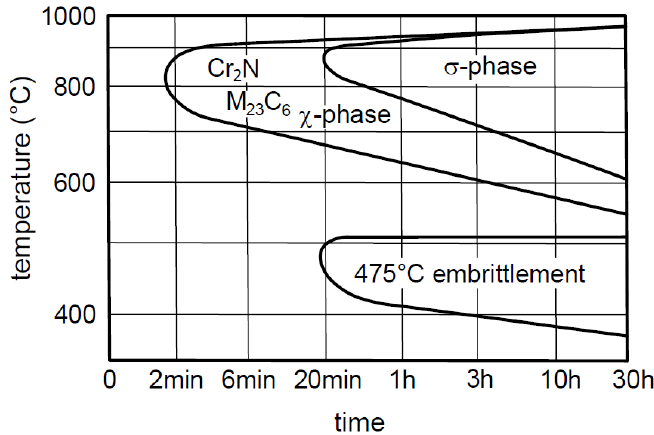
Figure 2. G. Herbstleb and P. Schwaab’s simplified precipitation diagram for duplex stainless steel.